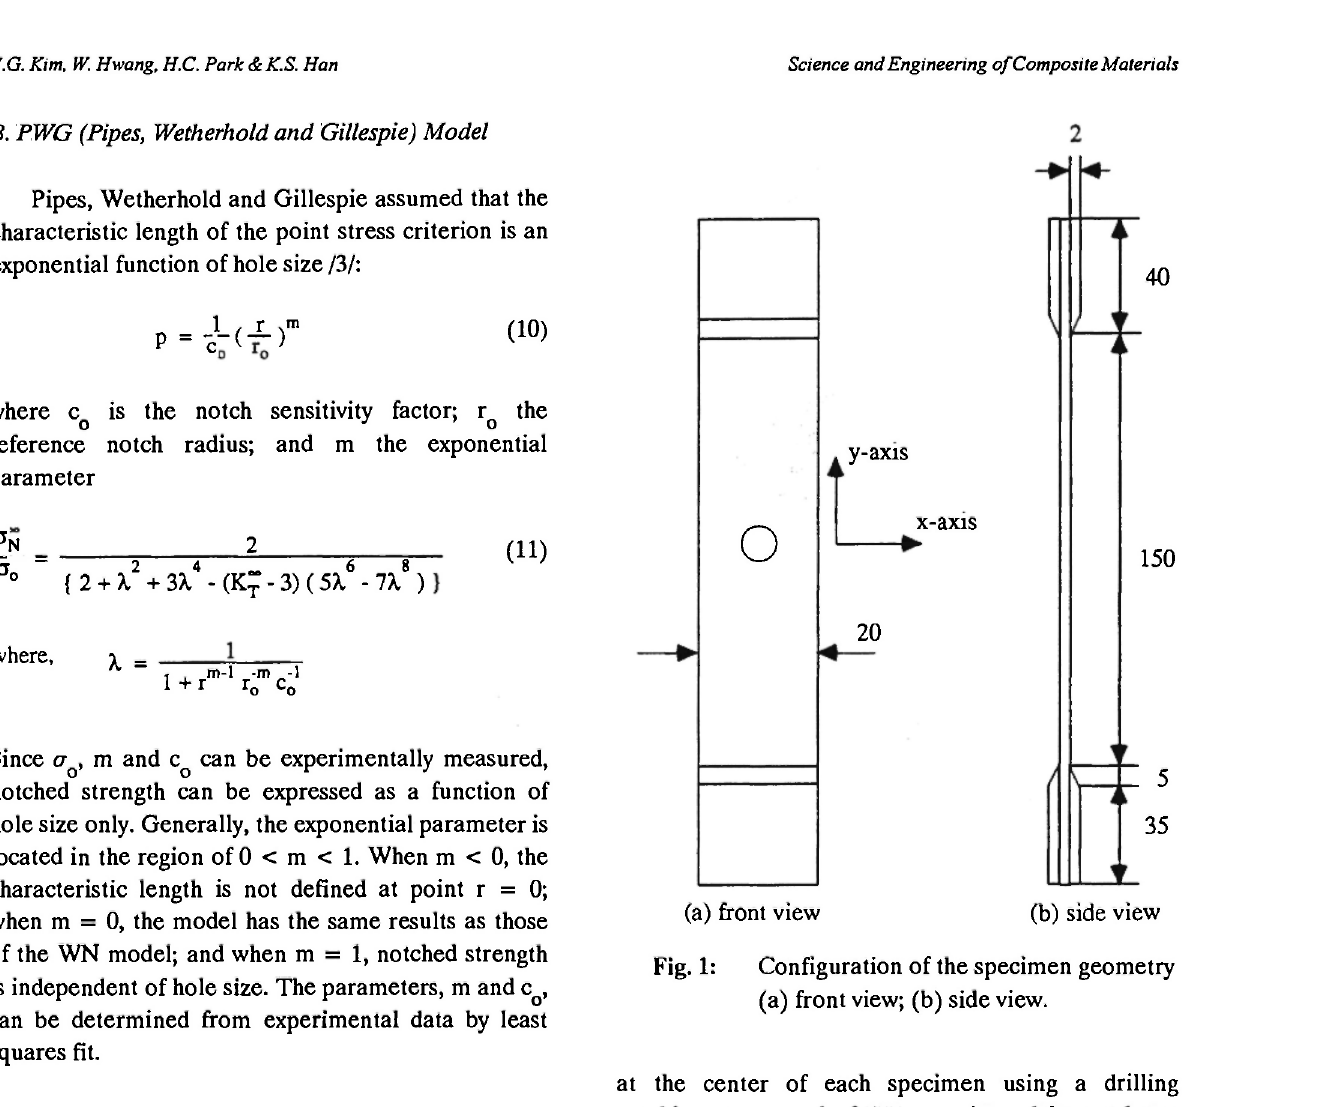
Fig. 1: Configuration of the specimen geometry (a) front view; (b) side